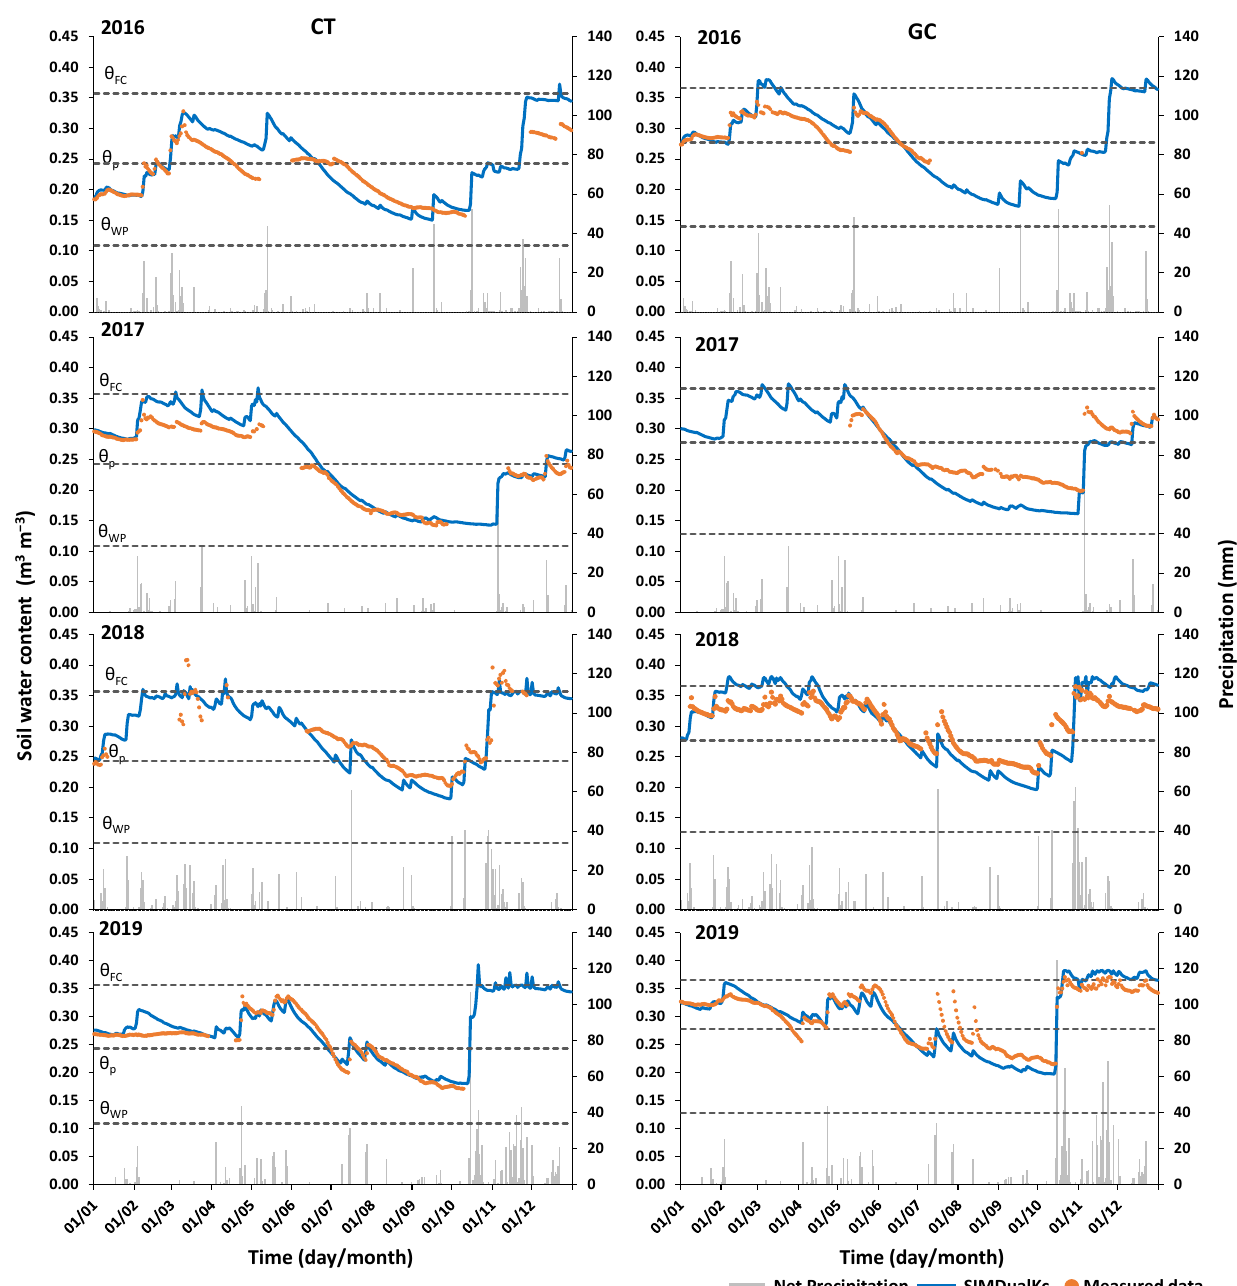
Figure 3. Measured and simulated soil water contents of the Monferrato conventional tillage (CT) and grass cover (GC) plots during the 2016–2019 growing seasons ( θ FC , θ WP , and θ p refer to soil water contents at field capacity, the wilting point, and at the depletion fraction for no stress, respectively).